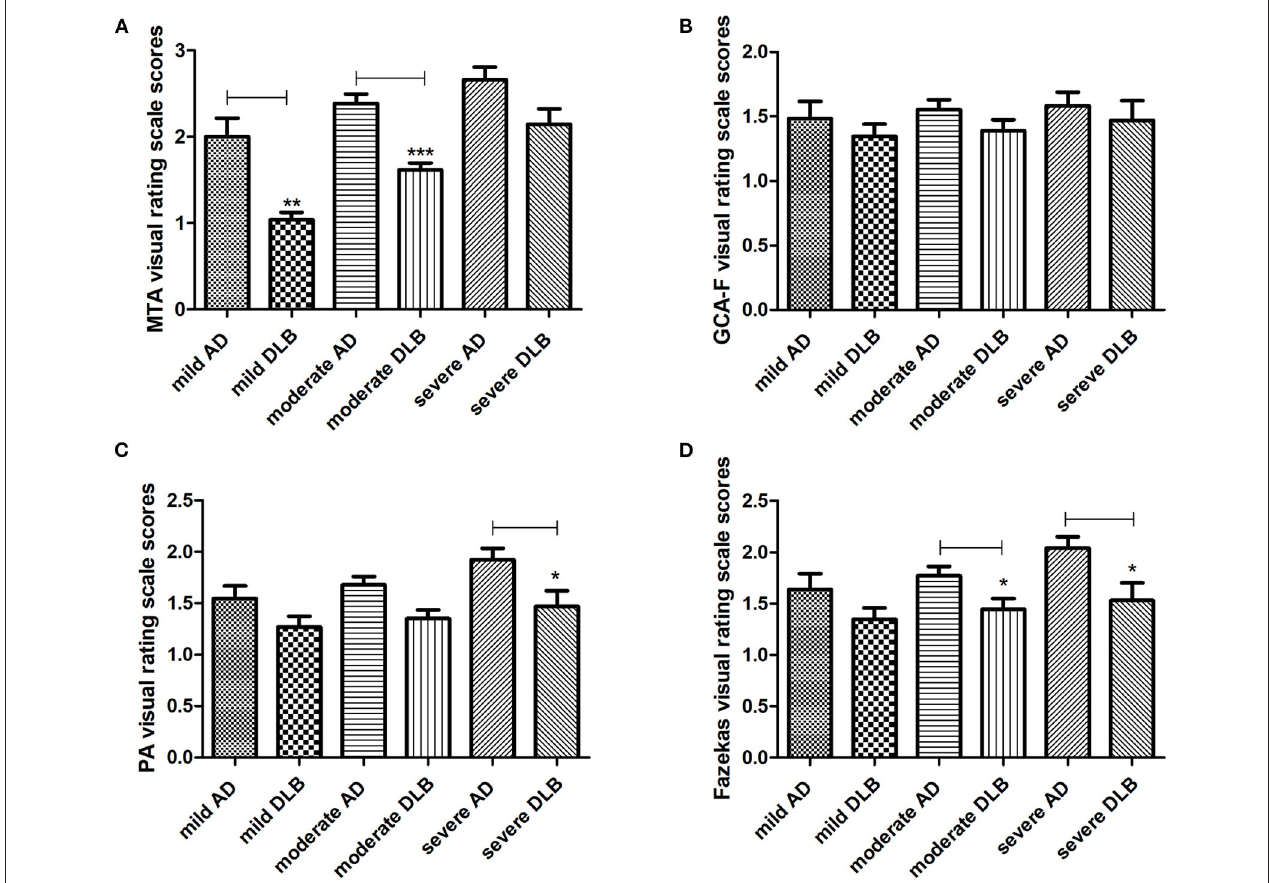
FIGURE 3 | MRI visual rating scales in AD and DLB subjects. The results of visual rating scale scores between AD and DLB groups under the same severity are described in (A–D) . AD, Alzheimer’s disease; DLB, dementia with Lewy bodies; MTA, medial temporal lobe atrophy; GCA-F, global cortical atrophy-frontal subscale; PA, posterior atrophy. *The results showed significant differences between AD and DLB. * p < 0.05, ** p < 0.01, *** p < 0.001.